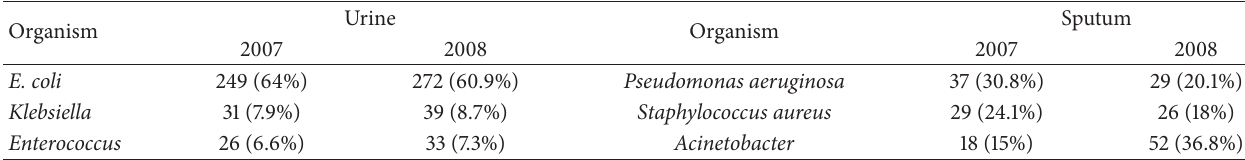
Table 1: Annual prevalence of microorganisms with the highest